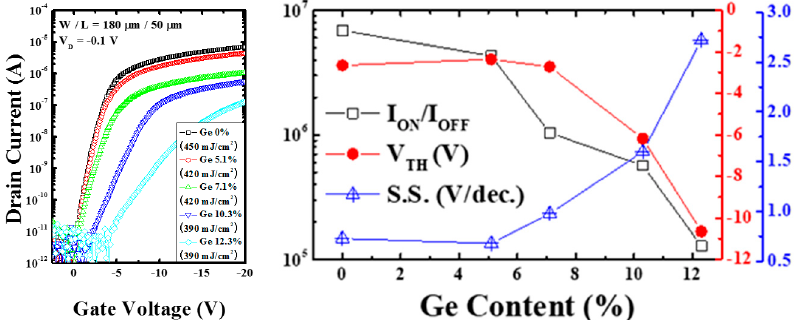
Figure 6. ( left ) Transfer characteristics; ( right ) electrical performance of poly-Si 1 − x Ge x TFTs as a function of the laser energy density and Ge concentration.